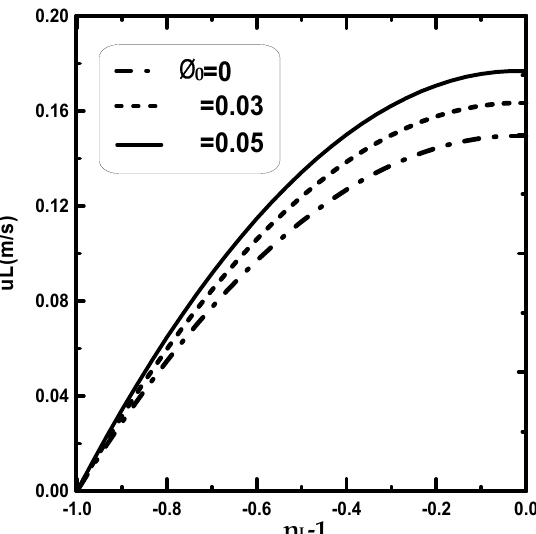
Figure 11. Evolution of the liquid velocity at the exit channel for different values of nanoparticle volume fraction: T 0L = 293.15 K, T 0 = 293.15 K, c 0 = 0, q 1 = 3000 W/m 2 , m 0L = 15 × 10 − 4 Kg/m.s , T w = 293.15 K, u 0 = 1 m/s, H = 1 m, d = 0.015 m, p 0 = 1 atm.